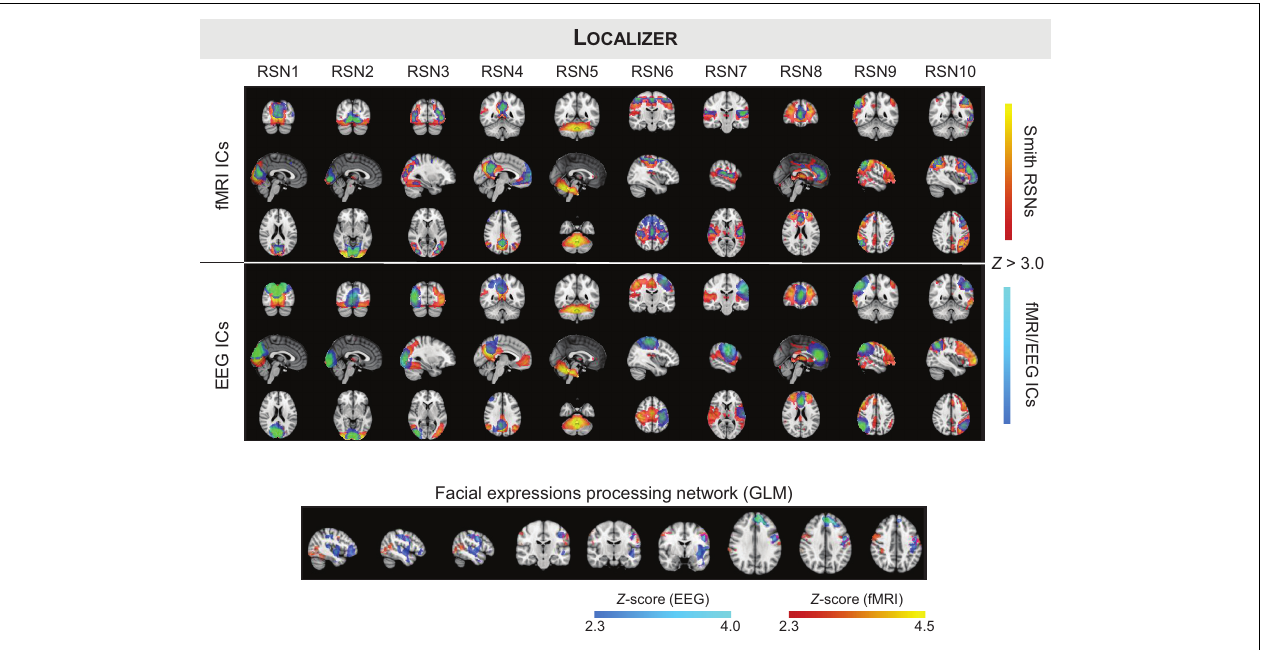
FIGURE 2 | Same as in Figure 1 , but showing the group RSNs identified on fMRI and EEG-ESI data for the localizer run. The group activation maps of the task-specific facial expressions processing network using fMRI (in red–yellow) and EEG (in blue–light blue) are also shown at the bottom, with the overlapping regions highlighted in